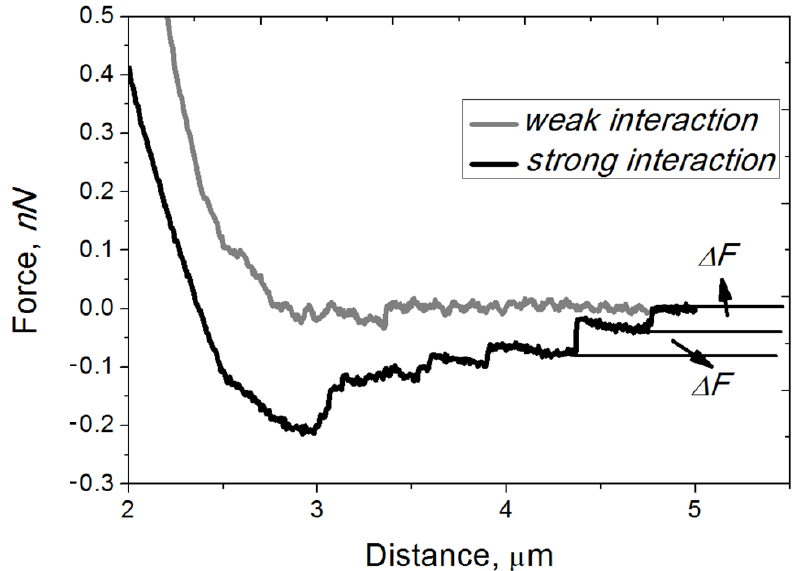
Figure 2. Typical curves depicting the interaction between an endothelial cell and a neutrophil, while the neutrophil was immobilized on the probe and the endotheliocyte adhered to the surface of the Petri dish. The black curve shows a strong adhesive contact between two cells, as steps are clearly visible ( Δ F ). The gray curve shows a weak (non-specific) contact, i.e., there are no steps.